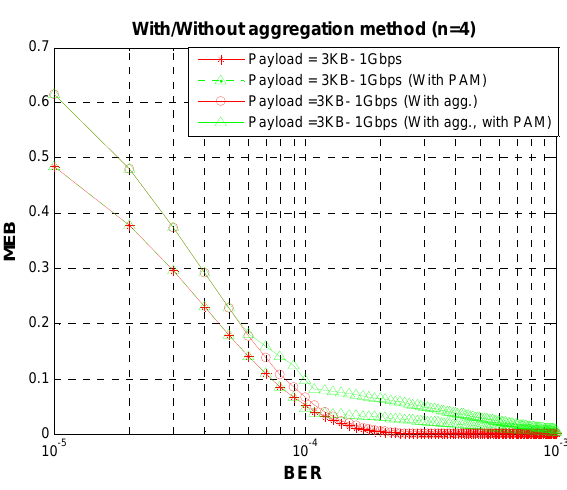
Figure 18. MEB versus BER value.